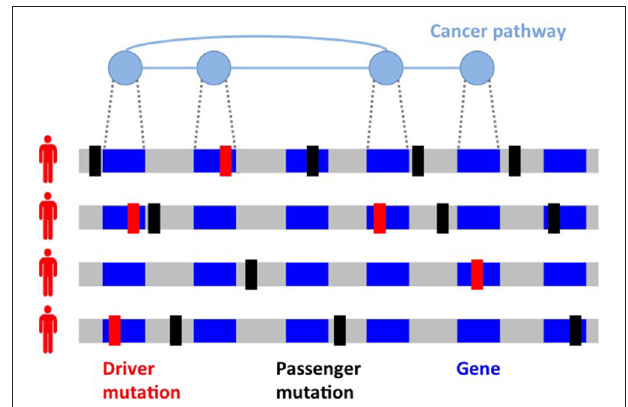
FIGURE 1 | Inter-tumor heterogeneity and its causes. Driver mutations (in red) target genes which are members of different cancer pathways , sets of interacting genes which perform specific functions and are altered in cancer. Passenger mutations (in black) not related to the disease comprise the majority of mutations in a tumor. Different mutated genes in cancer pathways and different passenger mutations are observed in tumors of the same type, with two cancer genomes often having no mutation in common.